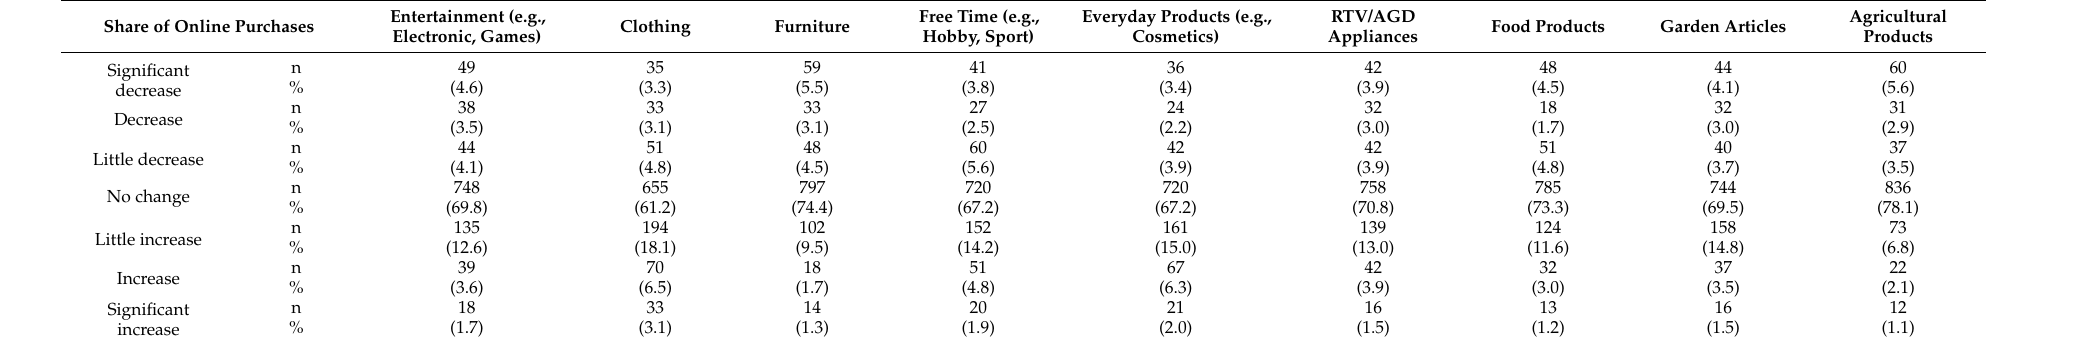
Table 2. Changes in online purchase frequency before and during the COVID-19 pandemic (own elaboration).